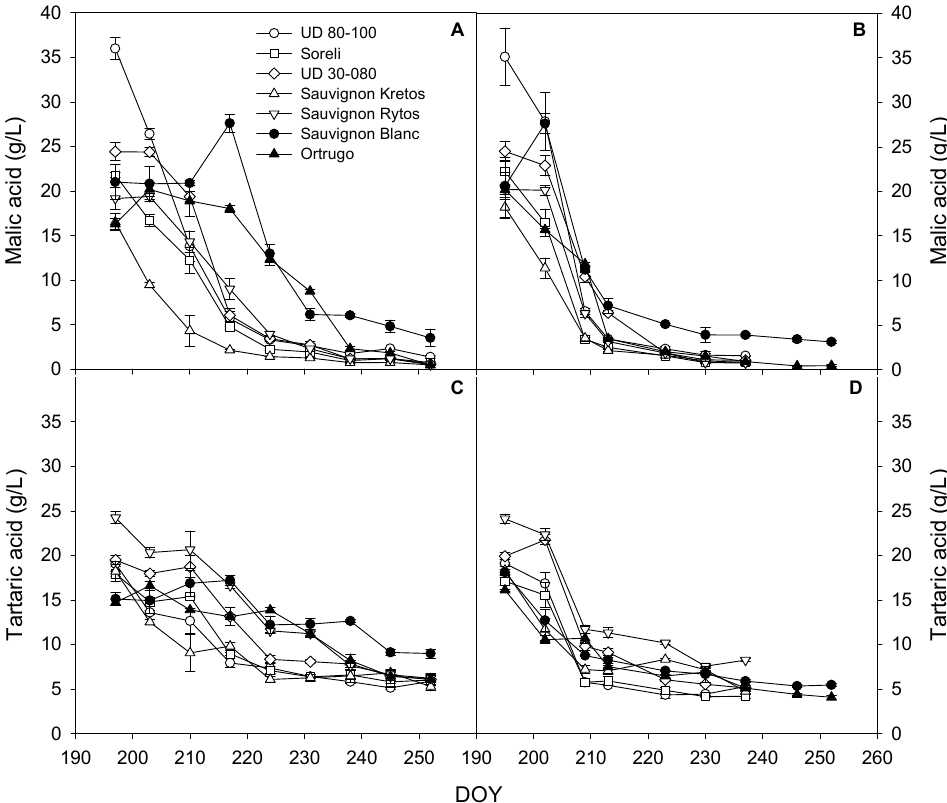
Figure 4. Seasonal evolution of grapes malic acid (panels A , B ) and tartaric acid ( C , D ) in 2019 ( A , C ) and 2020 ( B , D ) for 5 pathogens-resistant varieties (white symbols) and 2 reference V. vinifera cultivars (black symbols). Each point represents the average of three replicates ± SE. DOY = day of year.